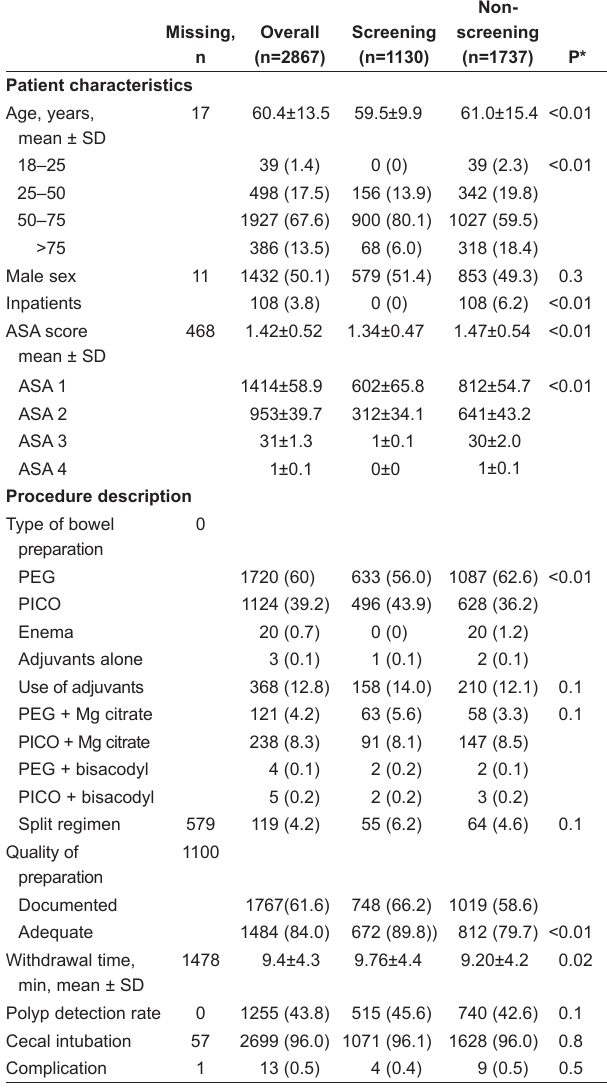
TAble 1 Patient characteristics and procedure description